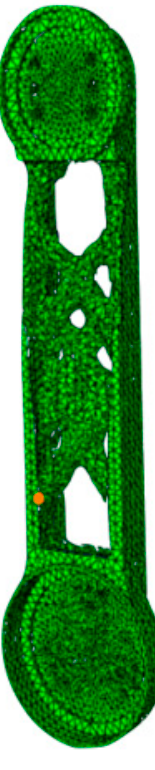
Figure 18. Usable topological structure.